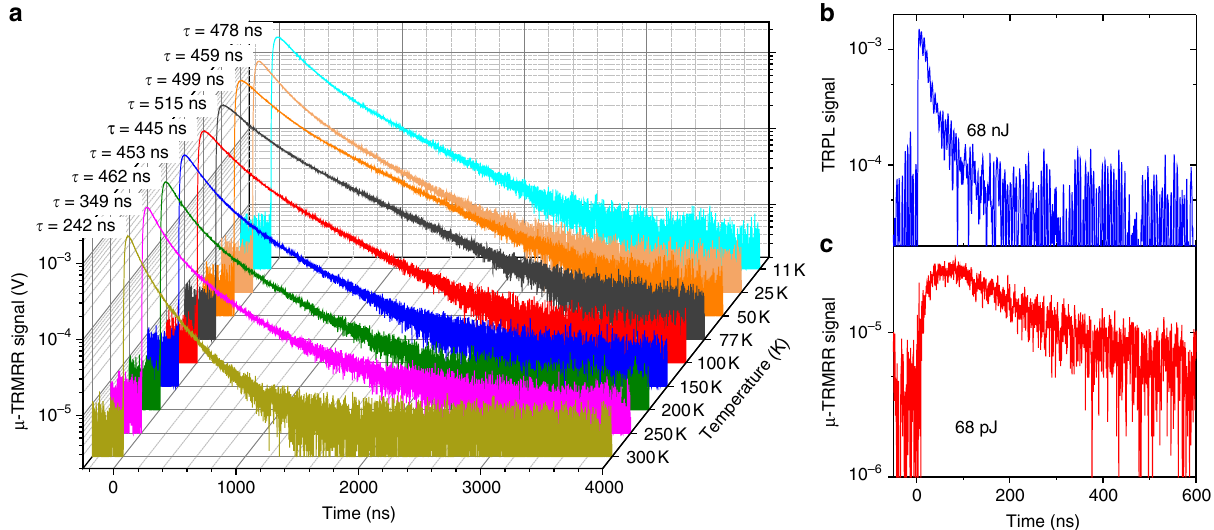
Fig. 5 Transient decay curves. a Temperature-dependent micro-scale time-resolved microwave resonator response ( μ -TRMRR) signal from InAsSb pixel (35.5 pJ pulse energy on pixel, 2000 averages on oscilloscope). Extracted lifetimes are shown above each curve. b Time-resolved photoluminescence (TRPL) response of pixel array with 68 nJ laser pulse energy (16.6 nJ incident on pixels) and c µ -TRMRR data for a single pixel with 68 pJ pulse energy (35.5 fJ incident on pixel). Both experiments in b and c are performed at 300 K, with 2000 averages on the oscilloscope. We see that a comparable response is obtained from the μ -TRMRR with >10 5 less energy than is needed for